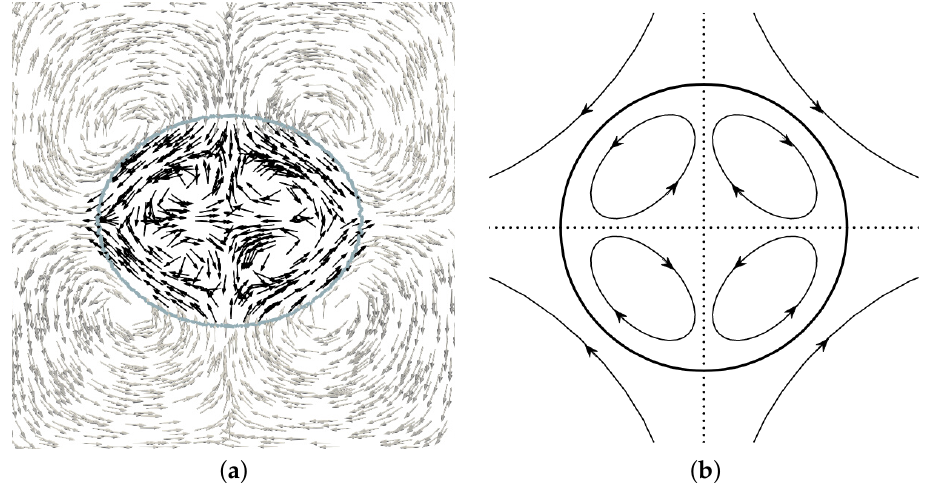
Figure 6. Comparison between the orientation of induced flows inside and outside of the droplet with S > R : ( a ) Numerical results ( b ) Taylor’s theory